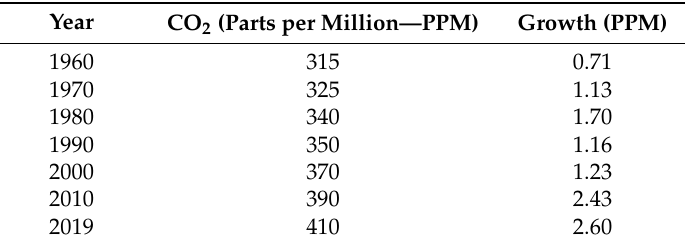
Table 1. CO 2 emissions trend over the